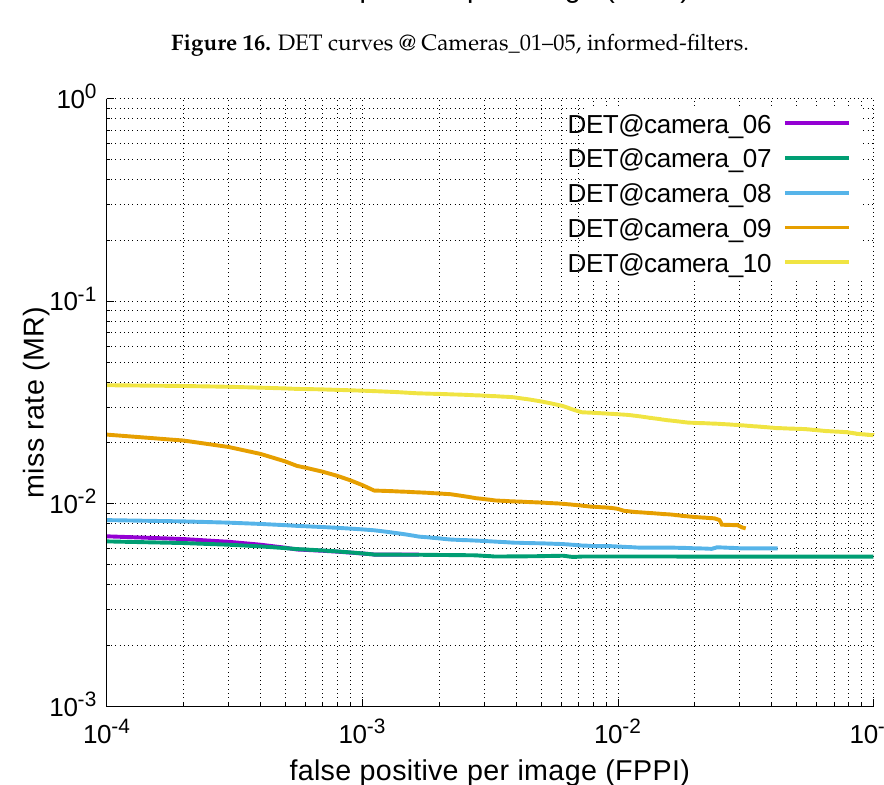
Figure 17. DET curves @ Cameras_06–10,